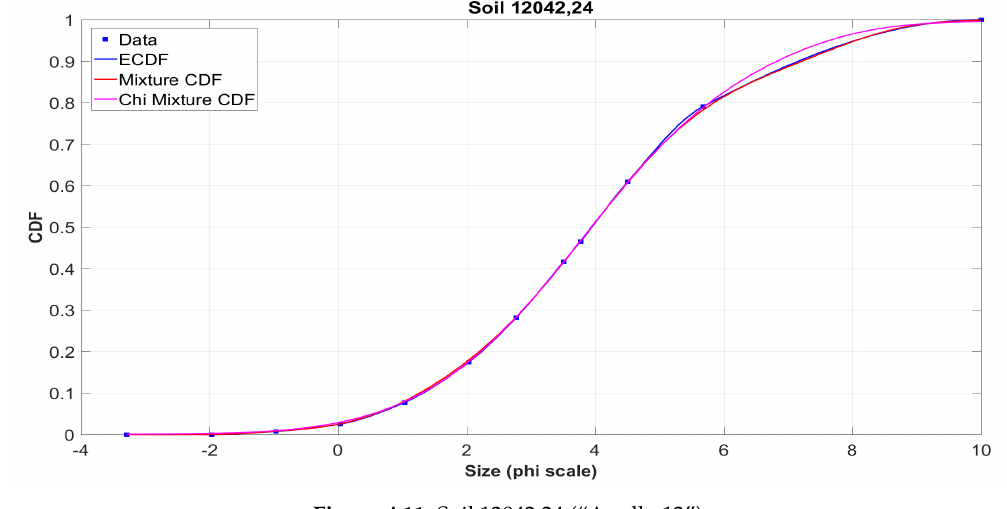
Figure A11. Soil 12042,24 (“Apollo 12”).